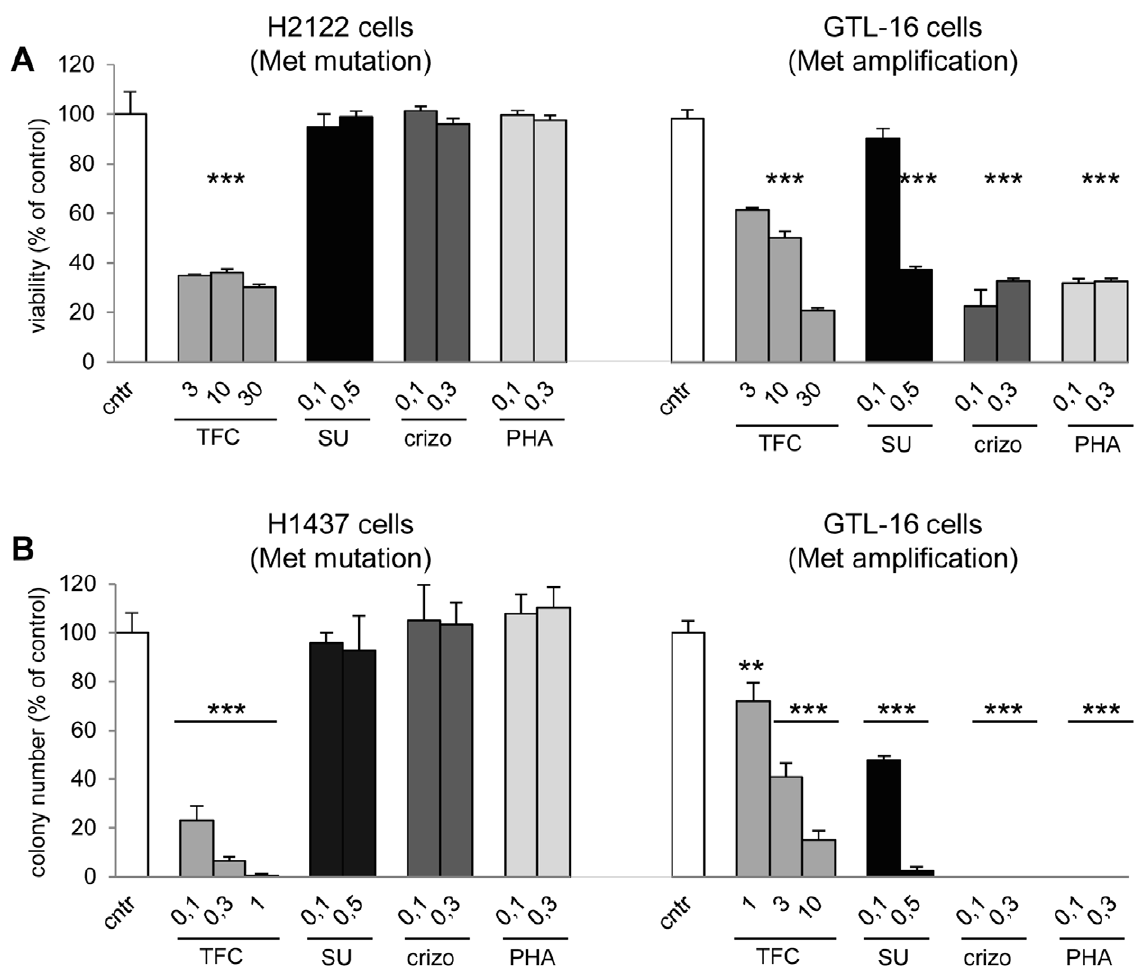
Figure 1. Triflorcas blocks Met-triggered cell survival and in vitro tumorigenesis of human NSCLC cells carrying Met mutations (H2212 and H1437) and of human gastric carcinoma cells carrying Met amplification (GTL-16). (A) Survival of H2122 and GTL-16 cells was reduced by Triflorcas at indicated concentration ( m M; n=3). In contrast, SU11274 (SU), crizotinib (crizo), and PHA665752 (PHA) impaired survival of GTL-16, but not of H2212 cells. Cells were serum-starved for 24 hours and then incubated with compounds for 48 hours. (B) Triflorcas blocked anchorage-independent growth of H1437 and GTL-16 cells in a dose dependent manner (n=3). SU11274, crizotinib, and PHA665752 impaired in vitro tumorigenesis of GTL-16, but not of H1437 cells. Values are expressed as means 6 s.e.m. **P , 0.01; ***P , 0.001; Student- t test.